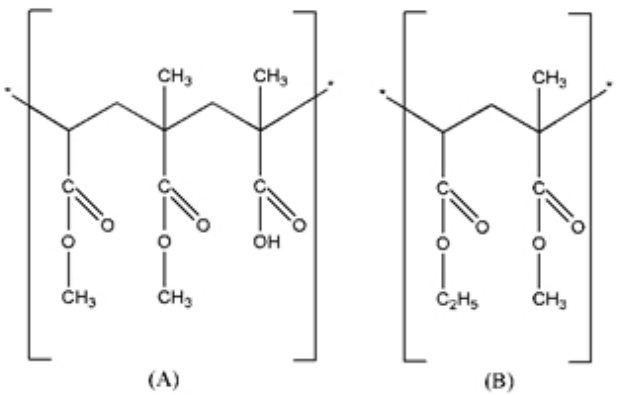
FIGURE 2 - Monomer of Eudragit ® FS30D (A) and Eudragit ® NE30D (B).